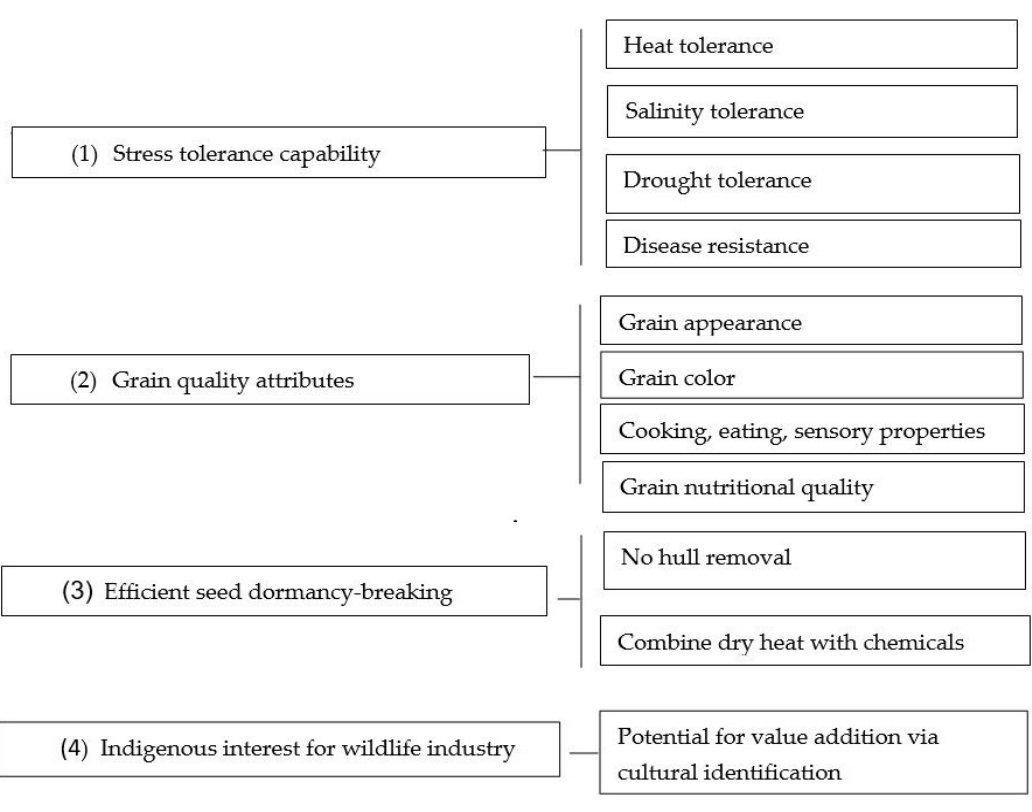
Figure 3. Factors supporting the establishment of a rice industry based on wild species in northern Australia.